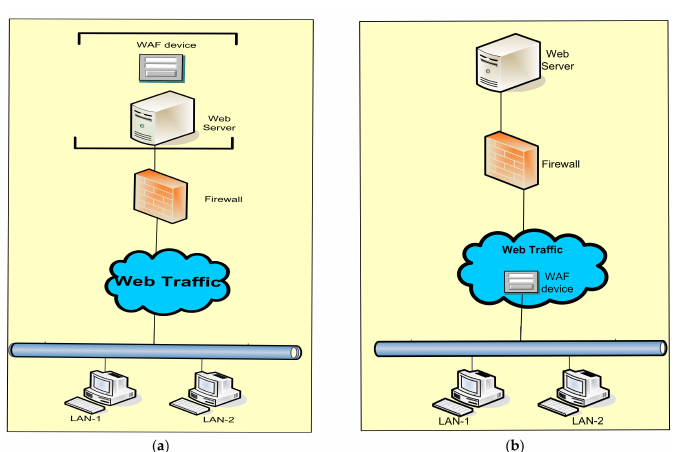
Figure 7. ( a ) Embedded web application firewall (WAF) topology, ( b ) internet hosted and cloud WAF